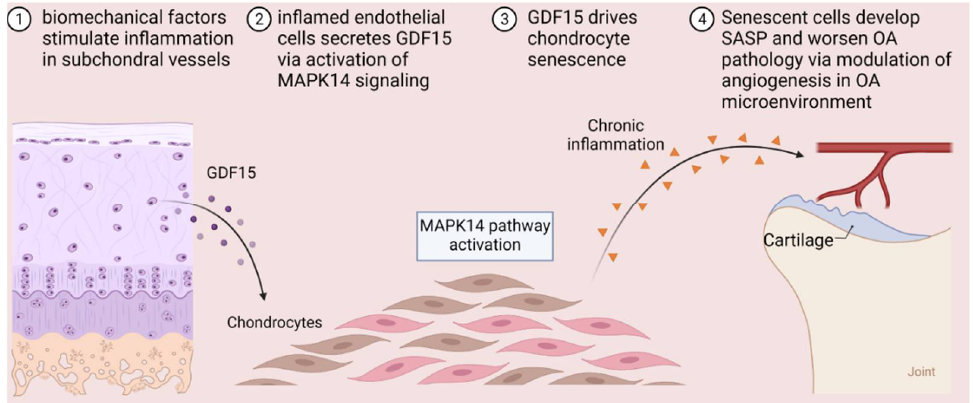
Figure 8. Schematic figure of cellular senescence induced by GDF15/MAPK14 signaling axis in chon- drocytes of